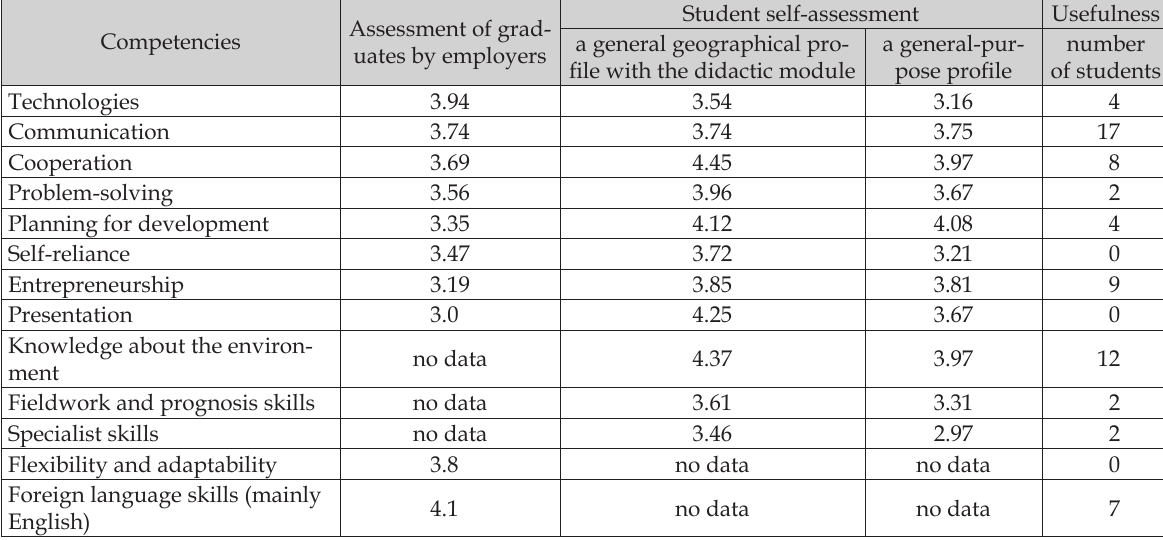
Table 2. Comparison of self-assessment of AMU students of geography in the field of academic and didactic competencies with the assessment of employers.